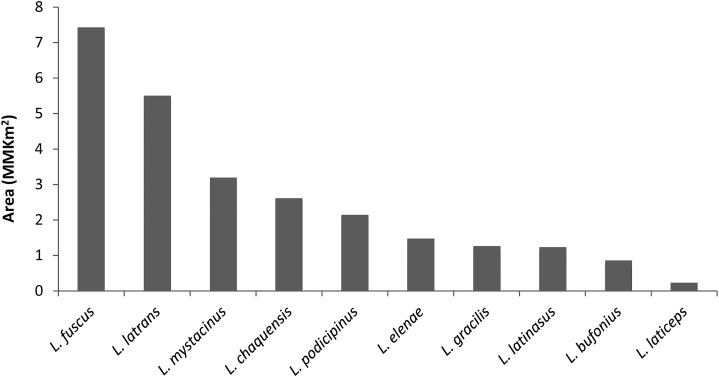
Distribution area (in MMKm2) of Leptodactylus chacoan species.